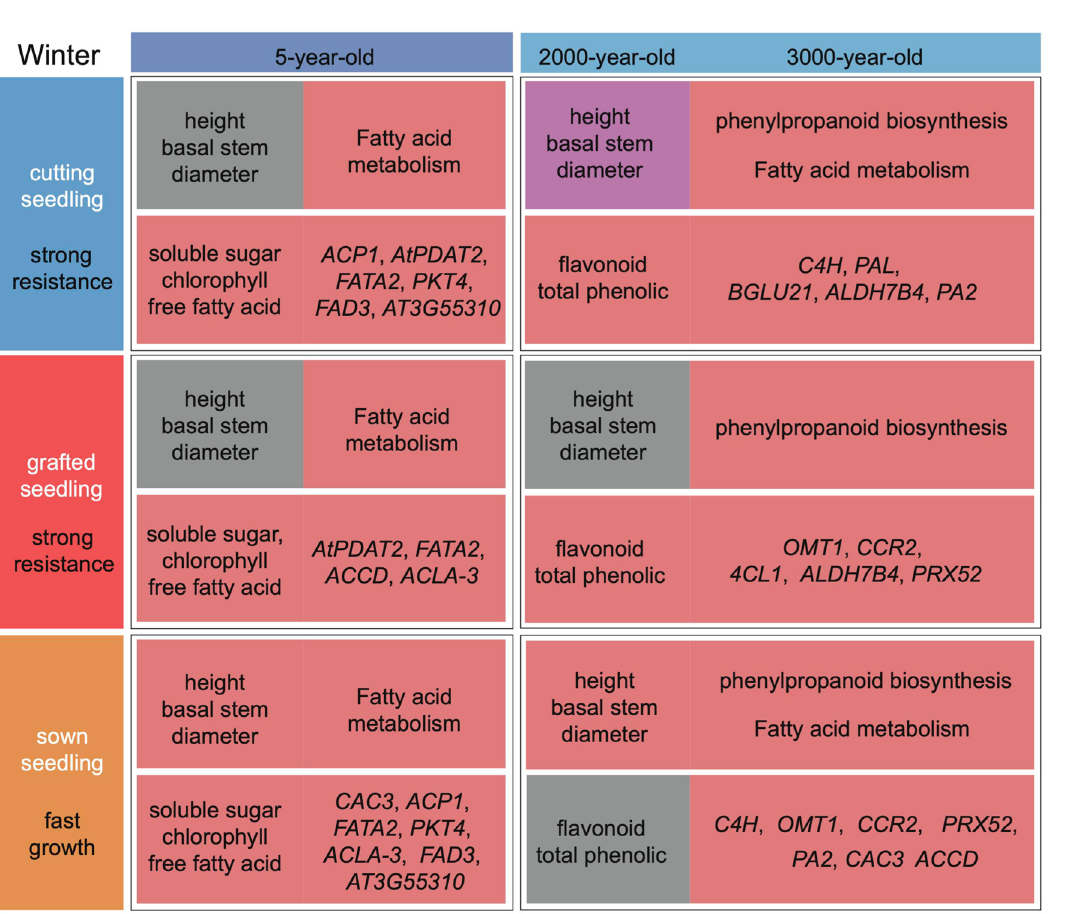
Figure 9. Framework plots of growth indicators, physiological indicators, and molecular expression levels of P. orientalis propagated from donors at different ages (5-, 2000-, and 3000-year-old) in different methods (seed sowing, cutting, and grafting). Red represents high values, grey represents medium values, and purple represents low values.